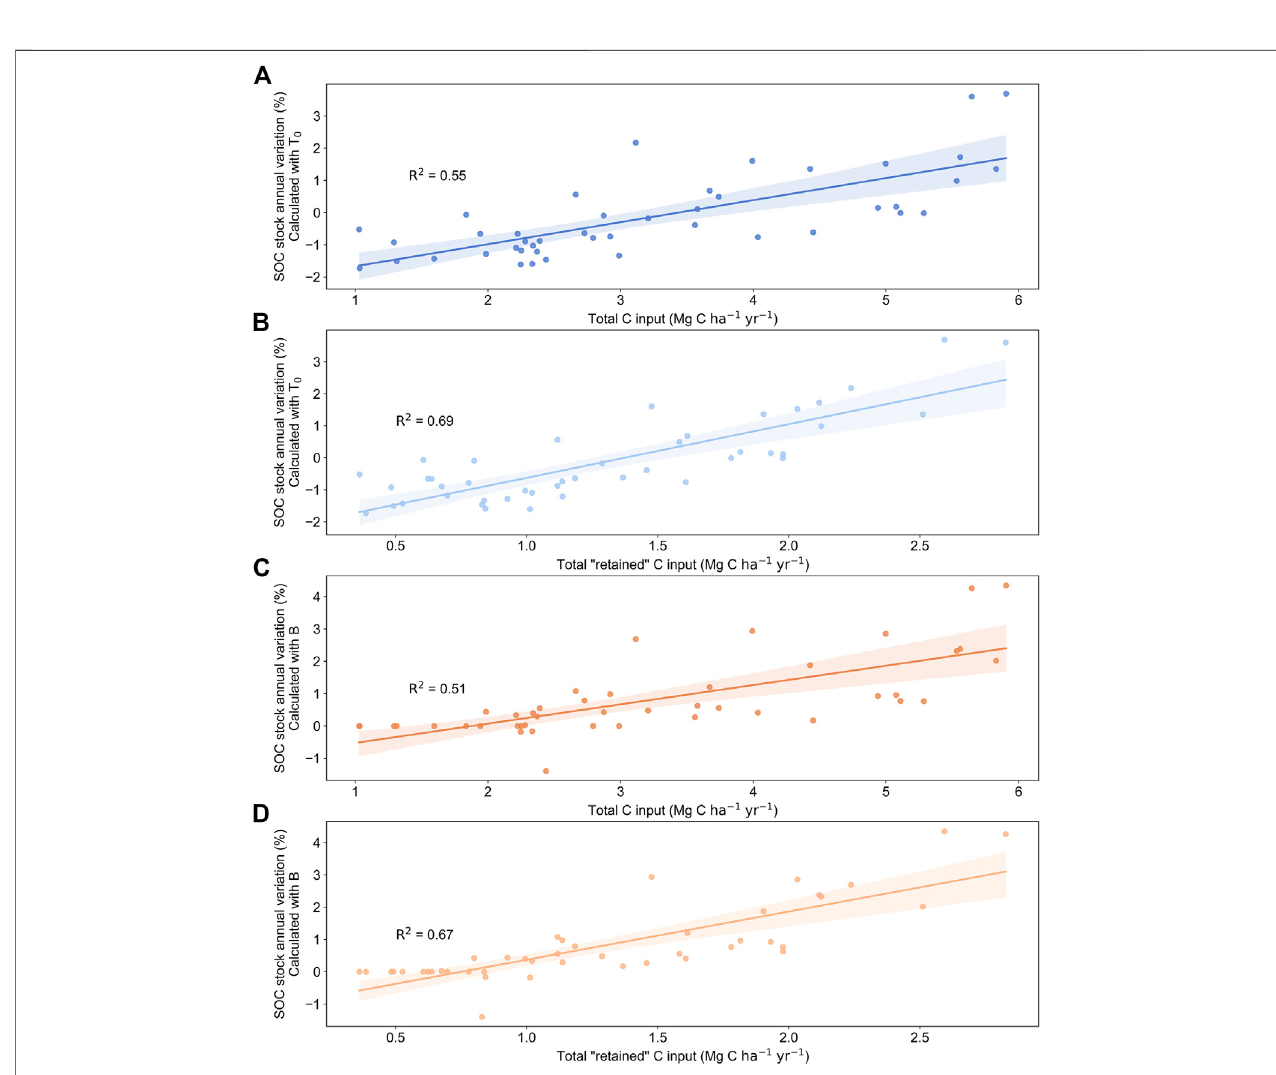
FIGURE4| Relationshipbetweensoil organiccarbon (SOC) stockannualvariation(%)and1) totalcarbon (C)input(Mg C ha − 1 yr − 1 )[panel (A) and (C)